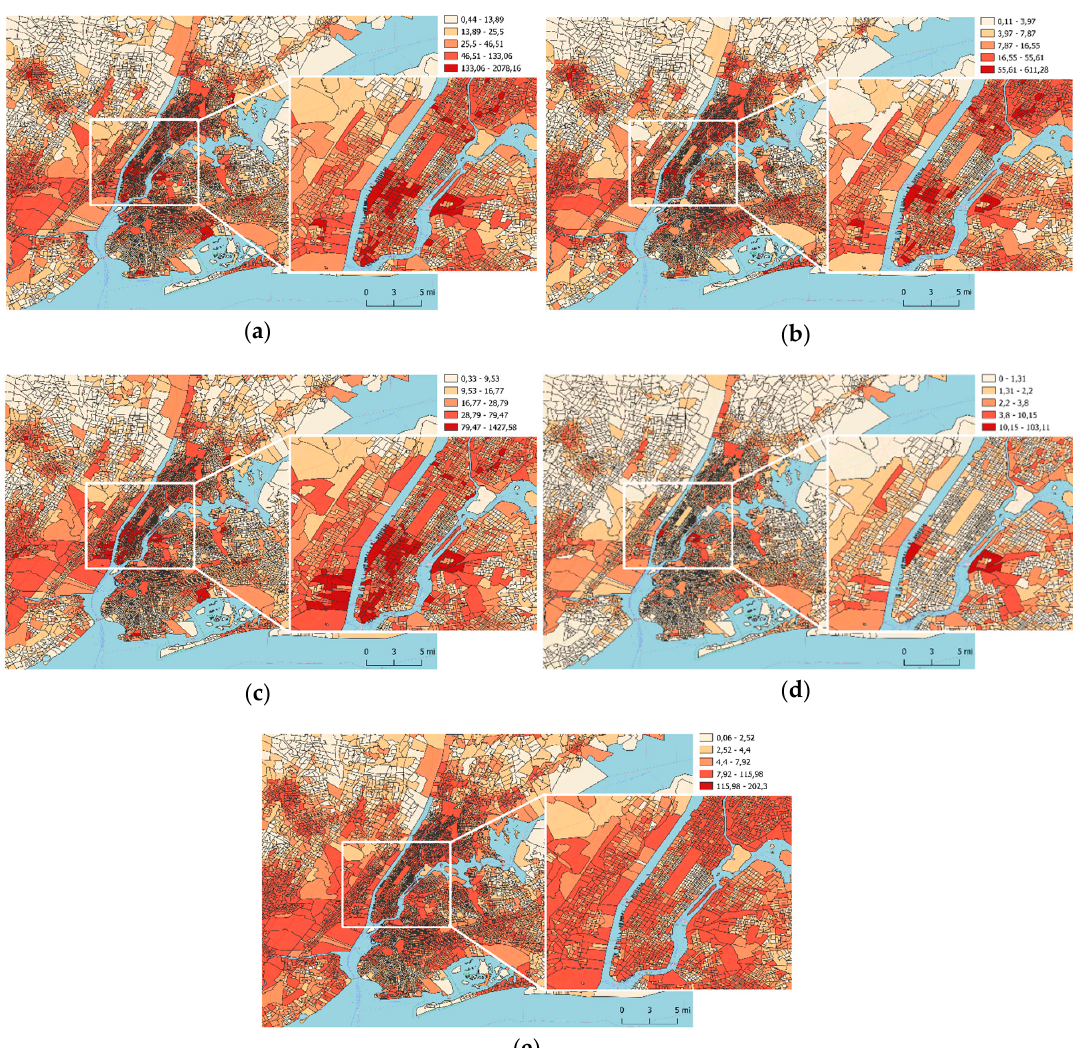
Figure 4. Map visualizations of yearly-predicted crime occurrences in New York City. ( a ) Predicted total crime (count) occurrences; ( b ) predicted violent crime occurrences; ( c ) predicted property crime occurrences; ( d ) predicted MVT occurrences; ( e ) predicted vandalism acts. Categories used to generate maps (from light to dark) correspond to the first quartile, second quartile, third quartile, fourth quartile (excluding the 2 highest centiles), and the two highest centiles of crime count predictions, respectively. Basemap obtained from OpenStreetMap, and U.S. Census Block Groups delimitations were extracted from the Tiger Census Shapefiles.